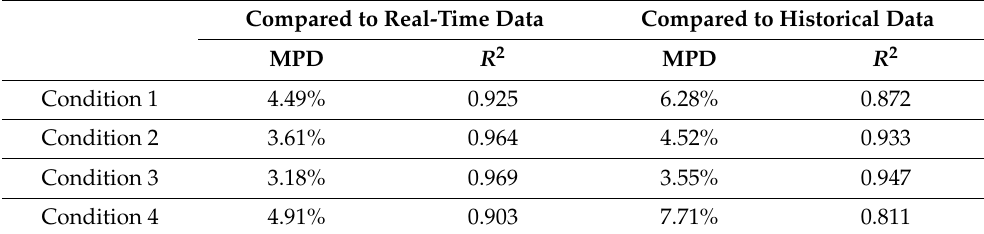
Table 2. Comparison of DT-driven predictions and actual data of ship engine system. Compared to Real-Time Data Compared to Historical Data MPD R 2 MPD R 2 Condition